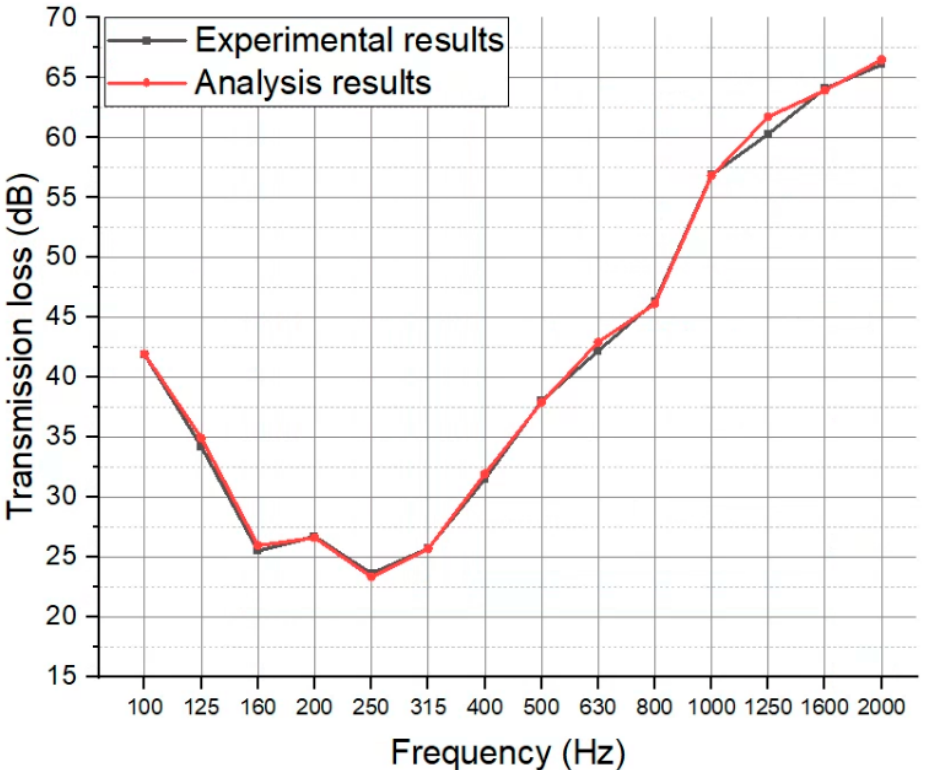
Figure 6. Comparison of experimental results and simulation results.